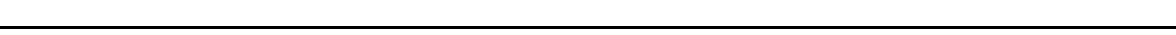
Fig. 5 SCAT7 acts as an oncogenic driver in renal, lung, and liver cancers. a SCAT7 expression as log 2 fold change across cancer types from TCGA data sets. The signi fi cance was obtained using Benjamini – Hochberg ’ s method. b MTT of Caki-2, A549, and HepG2 cells upon SCAT7 KD with two shRNAs or siRNAs. c Cell cycle pro fi les of Caki-2, A549, and HepG2 cells after shRNA or siRNA-based SCAT7 KD. d Percentage of apoptotic cells in SCAT7 KD Caki-2 and A549 48 h post-seeding. e Migration areas for stable SCAT7 KD Caki-2 and A549 cells were calculated with respect to a starting ( t = 0) migration control area for each cell line. f Matrigel transwell assay in Caki-2 and A549 SCAT7 stable KD cells. The number of invasive cells was counted 24 h post-seeding. g Soft agar colony-forming assay using Caki-2 and A549 KD cells. h MTT of HeLa, Caki-2, and A549 cells overexpressing SCAT7 . i Colorimetric β - galactosidase staining of BJ-BRAF and TIG3-BRAF human fi broblasts 72 h post-silencing SCAT7 using three siRNAs. Senescent cells are in dark blue color. j Quanti fi cation of senescent cells upon SCAT7 KD in BJ-BRAF and TIG3-BRAF cells shown as percentage of the whole cells populations. k SCAT7 qPCR in serial passages of BJ-BRAF cells. NS, not signi fi cant. l SCAT7 expression in BJ-BRAF cells at day 0 and day 3 upon tamoxifen-induced senescence (200 nM) at one passage interval. m MTT assay of BJ-BRAF cells overexpressing SCAT7 compared to empty vector. n Percentage of positively stained senescent cells 3 days post-tamoxifen treatment in control and SCAT7 -overexpressing BJ-BRAF cells. o , p Expression of SCAT7 , p16 , p15 ( o ) and IL8 ( p ) in control BJ-BRAF and SCAT7 -overexpressing cells at day 0 and day 3 post-treatment with tamoxifen. q Quanti fi cation of senescent cells upon SCAT7 KD in A549 cells. The values are expressed as percentage of the whole cell population. Note that the data presented in b – h and j – q represents mean values of three independent experiments and the statistical signi fi cance was derived using a two-tailed unpaired Student ’ s t -test. Data are plotted as mean ± SD (* p ≤ 0.05; ** p = 0.01 ̶ 0.001; *** p <